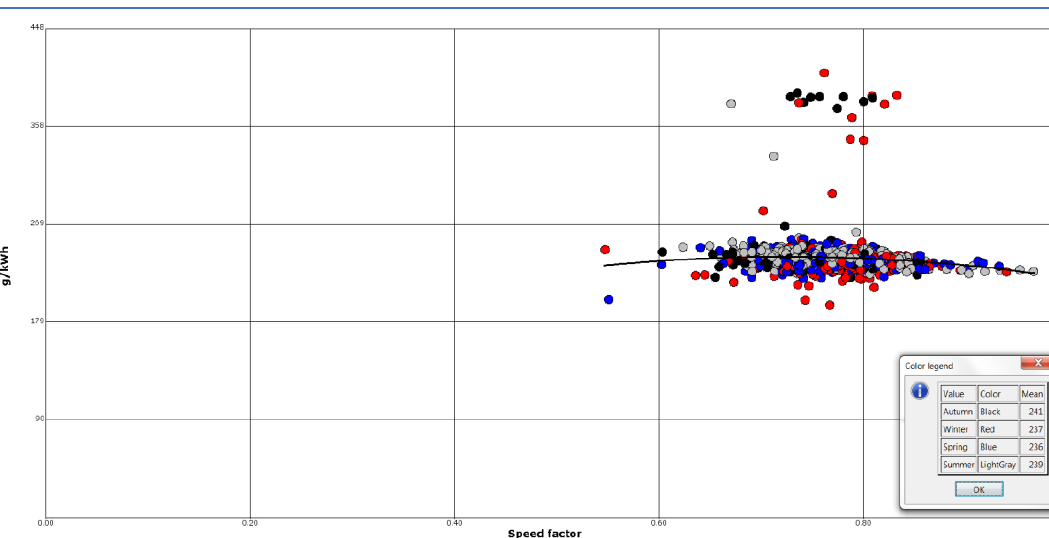
Figure 9. Specific fuel oil consumption (g/kWh) vs load factor (actual power over installed power) from Finnmarken. The gray line is a fitted second-degree polynomial trend line.